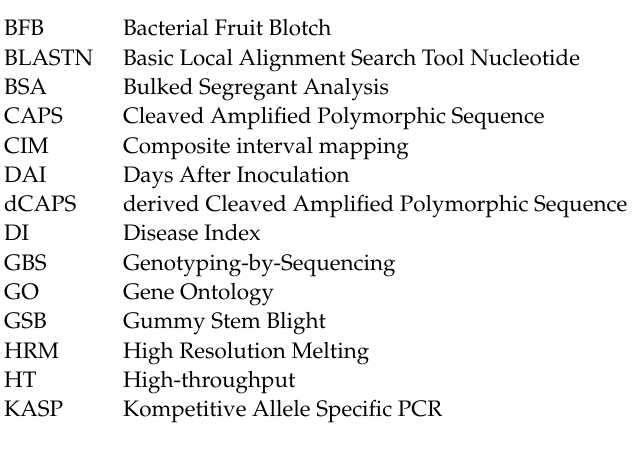
Figure S4: SNP genotyping of KASP™ markers for two parents, F 1 , 178 individuals of the F 2 population, Figure S5: Evaluation of disease severity using leaf lesion (LL) area, Figure S6: Symptoms caused by Didymella bryoniae on stem and petiole of test plants, Table S1: Inheritance of resistance to GSB in parental lines, F 1 progenies and F 2 population, Table S2: Summary of single nucleotide polymorphisms (SNPs) between watermelon lines ‘920533’ and ‘PI 189225’, Table S3: List of 88 polymorphic SNPs between ‘920533’ and ‘PI 189225’ developed into HRM marker, Table S4: Details of SNPs markers used for the genetic map construction in this study, Table S5: List of genes and their annotation in a QTL regions on chromosome 8, Table S6: Disease index (DI) scale for distinguishing resistance and susceptible plants to